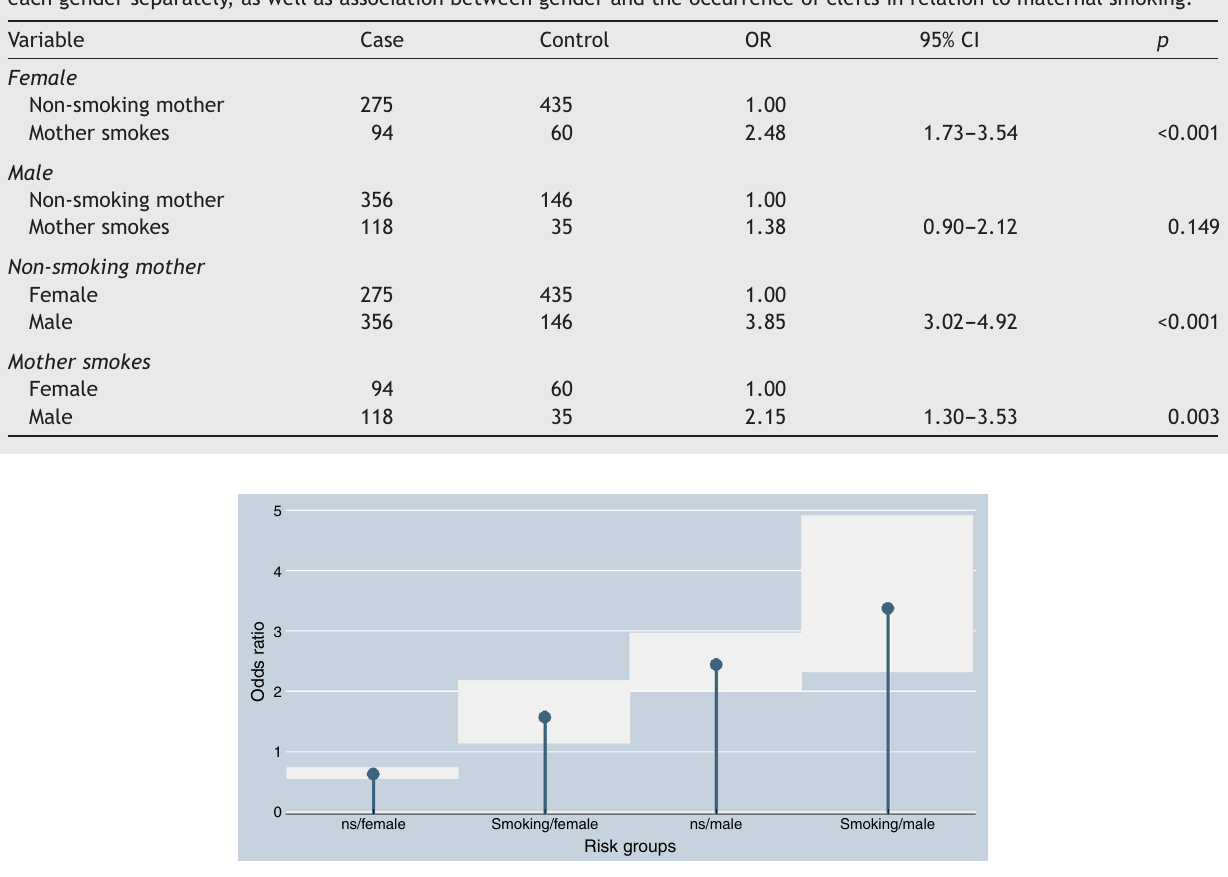
Figure 1 Association between maternal smoking status and gender with the presence of facial cleft deformities (ns, non-smoking). The squares represent the 95% confidence